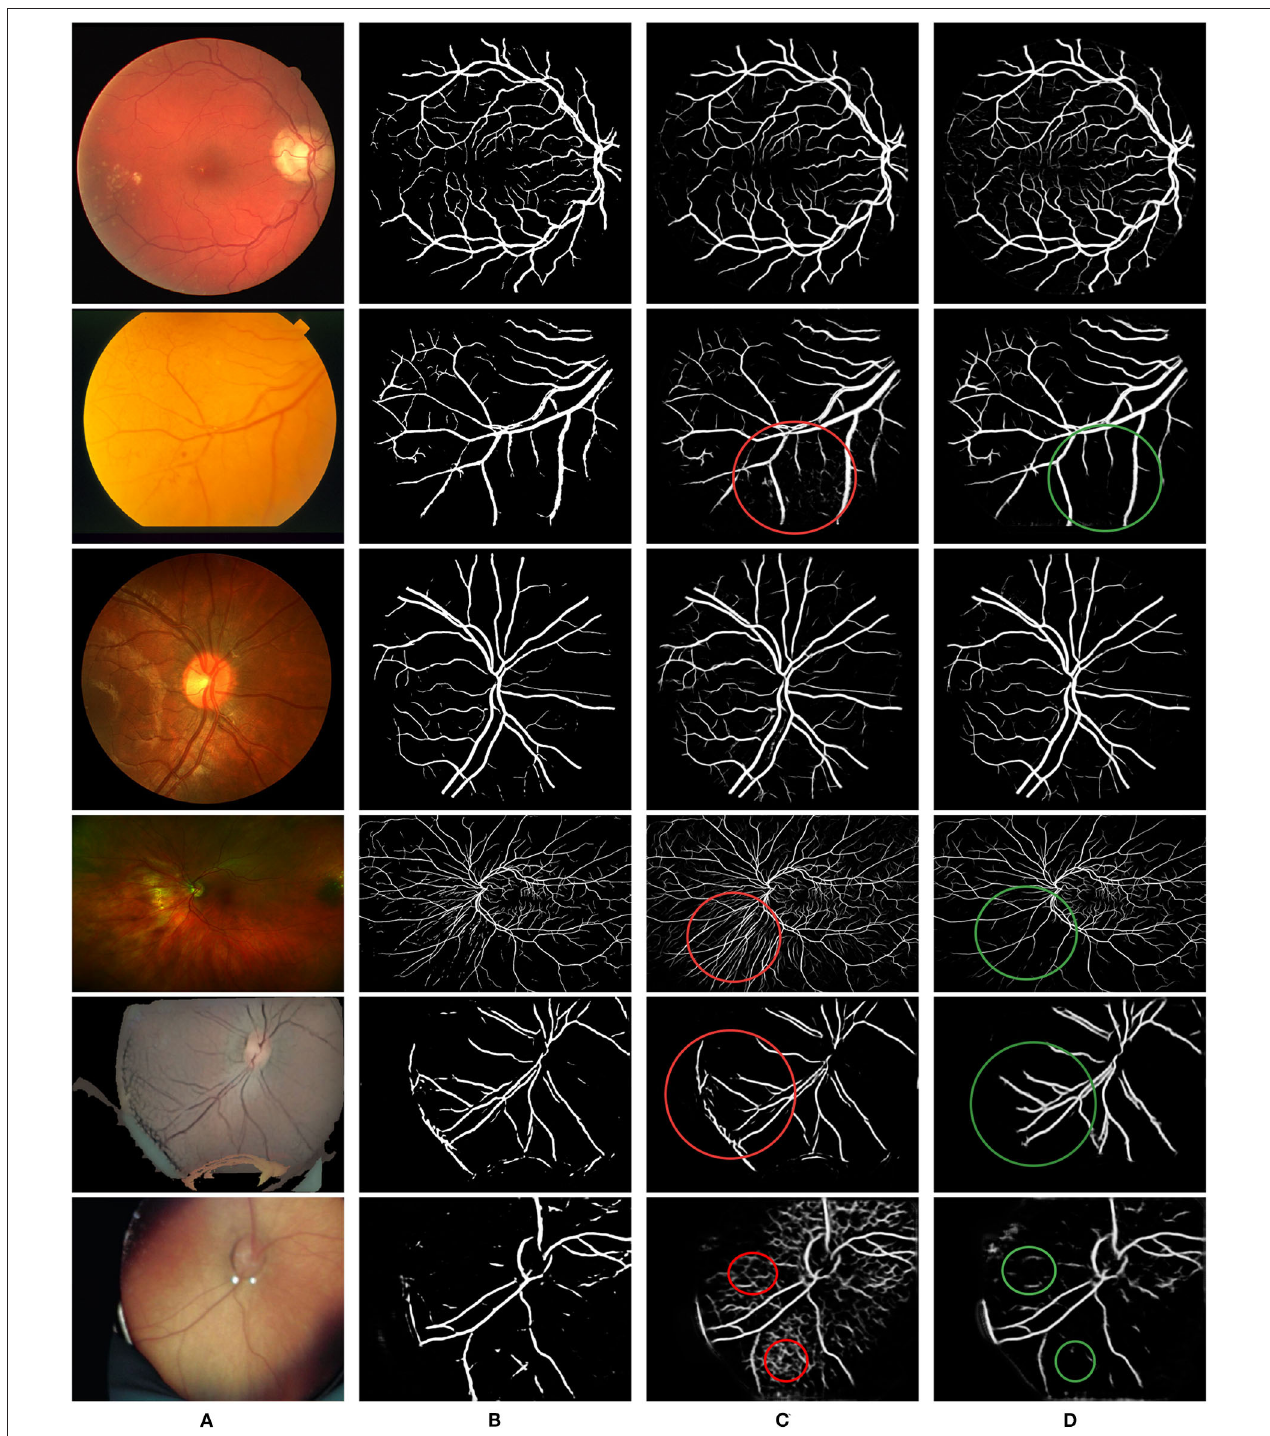
FIGURE 3 | Dynamic vs. fixed likelihoods maps: (A) Sample DRIVE, STARE, CHASE-DB, AV-WIDE, and VEVIO (Mosaics and Frames) images. (B) Likelihood map using weights estimated from the training data. (C) Likelihood map using equal weights for both classes. (D) Likelihood map using dynamic weights (see text for details). Dynamic weights allow the network to capture more vessels without introducing additional noise (examples highlighted in red circles). The noise in all but the next-to-last row consists of choroidal vessels, a frequent source of false positives in retinal vessel segmentation. The main artifact in the VEVIO frames is the rim of the handheld zooming lens used to capture these images (see Estrada et al., 2011 for details). Figure best viewed on-screen.